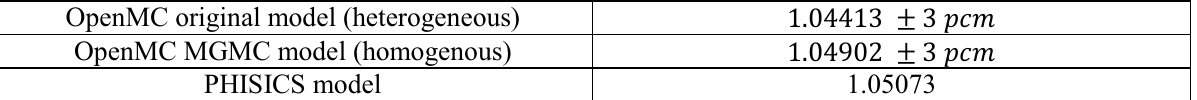
Table II. (cid:2) (cid:3)(cid:4)(cid:4) comparison among the different MYRRHA models